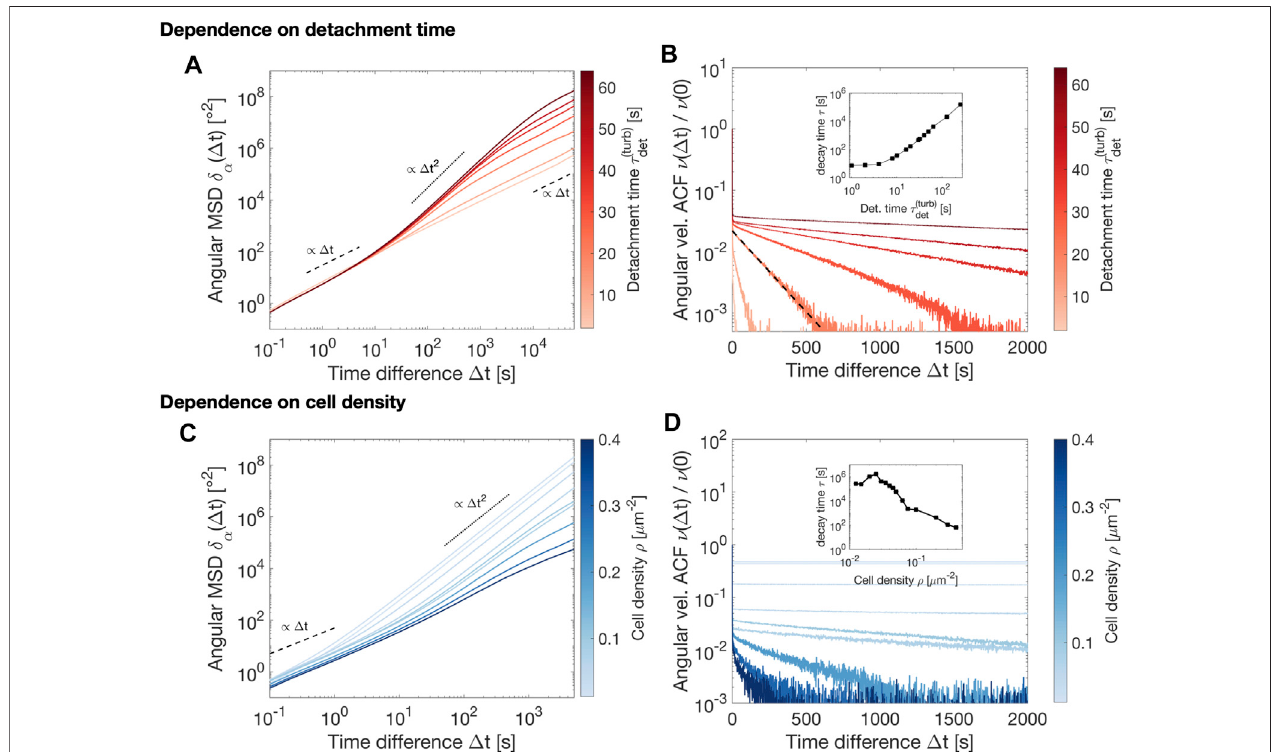
FIGURE3| Dependenceoftheturbinerotationonpilidetachmenttime τ ( turb ) det and celldensity ρ . (A,C) Angular meansquareddisplacement(angularMSD) δ α ( Δ t )of the turbine angle α as a function of the pili-turbine detachment time τ ( turb ) det (with the cell density at ρ =0.1 μ m 2 ) or cell density ρ (with the detachment time τ ( turb ) det (cid:2) 50 s). (B,D) Normalisedangular velocity autocorrelation function (angularvelocity ACF) ] ( Δ t )/ ] (0)oftheturbineangle α asafunctionofthepili-turbine detachment time τ ( turb ) det or cell density ρ . The inset fi gure shows the characteristic time scale of ] ( Δ t ), resulting from a fi t ] ( Δ t ) ∝ exp (− Δ t / τ ) . To account for the initial drop of the angular velocityACF,weonlydothe fi ttingfor Δ t > 2s.Anexample fi tisshownin (B) (blackdashedline).Pleasenotethatfortheinvestigationofthecelldensitydependenceofthe turbinerotation, weonly consider asmallerrange of Δ t toavoid toohighnumericalcost.Asaresult, wedonotshow thediffusiveregime intheMSDforlarge valuesof Δ t since the angular velocity ACF is decaying with increasing Δ t